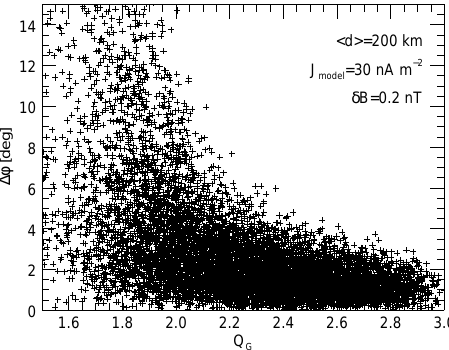
Figure 3. Deviation of the current density direction by the curlome- ter as a function of the tetrahedron’s quality